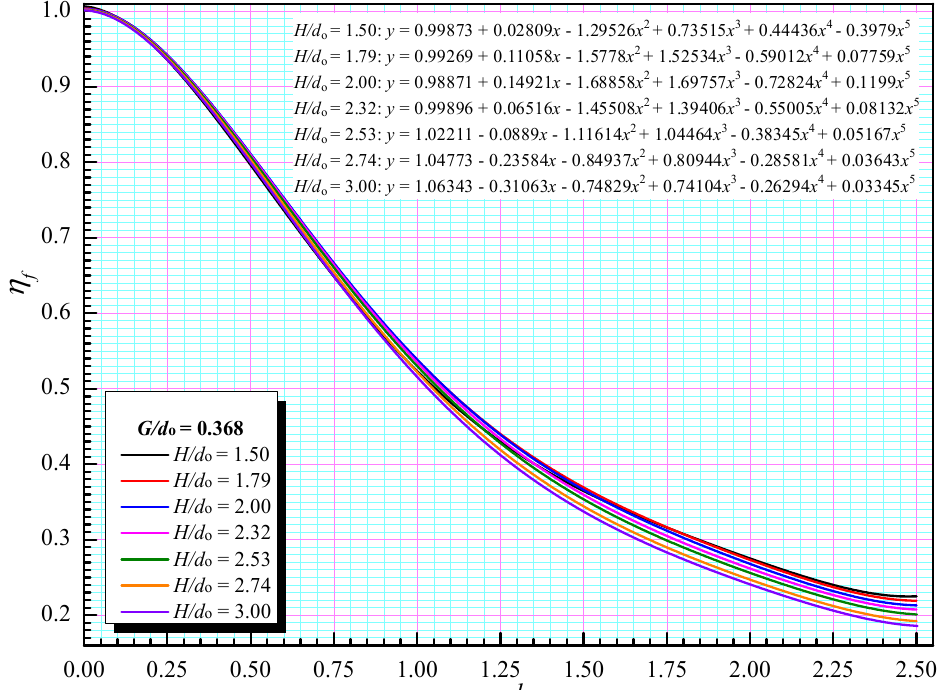
Figure 8. Linear nomograms and fitting formulae of fin efficiency at G / d o = 0.368.